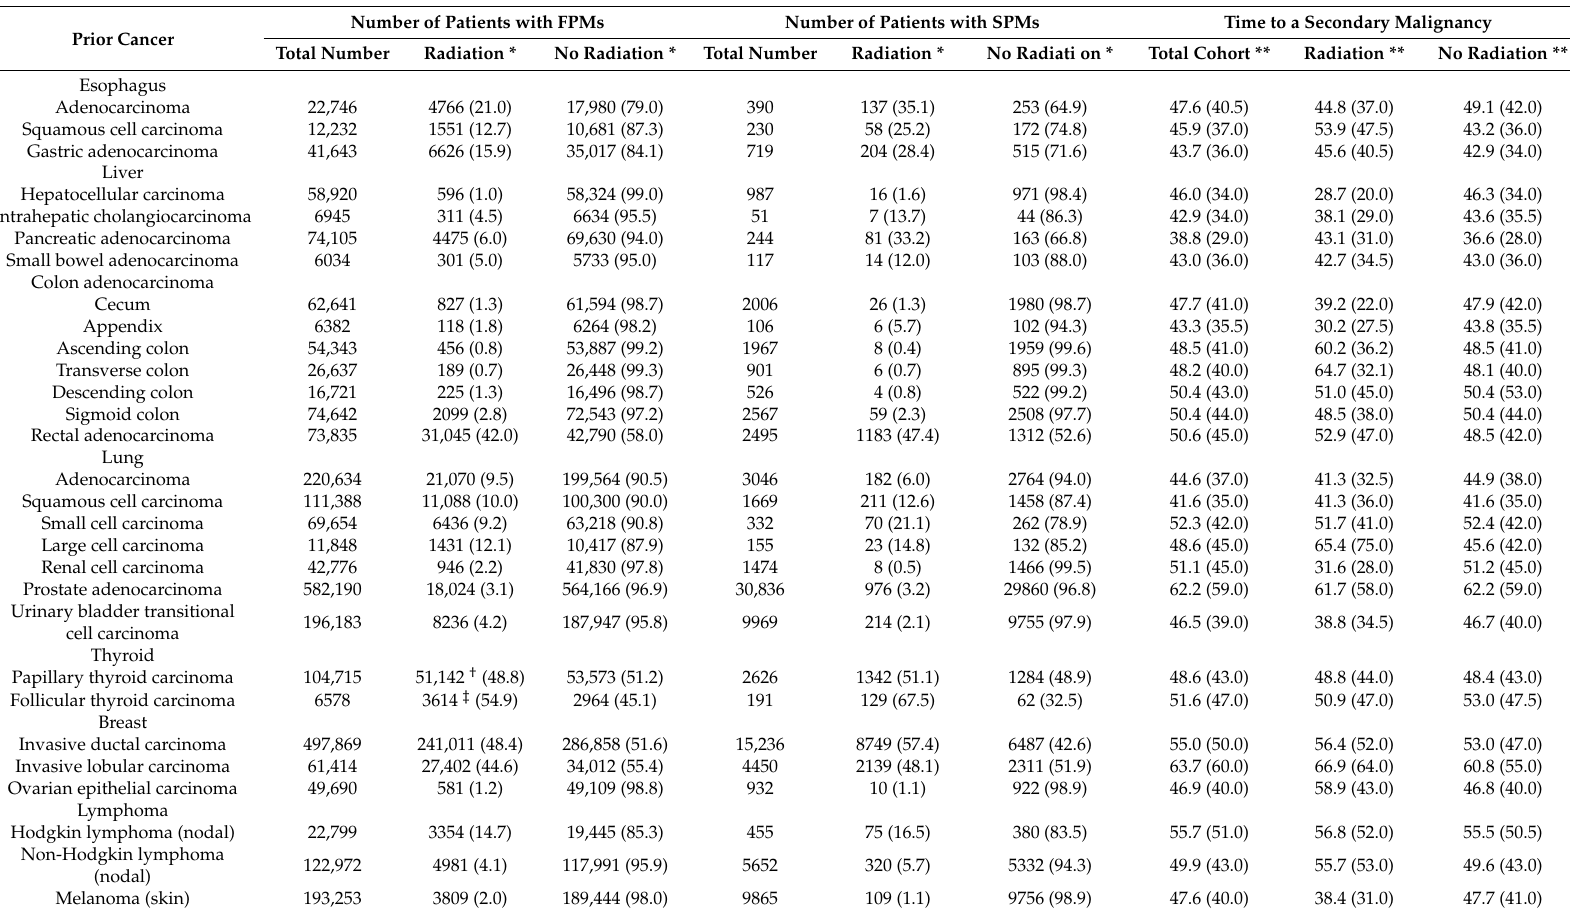
Table 1. Patient